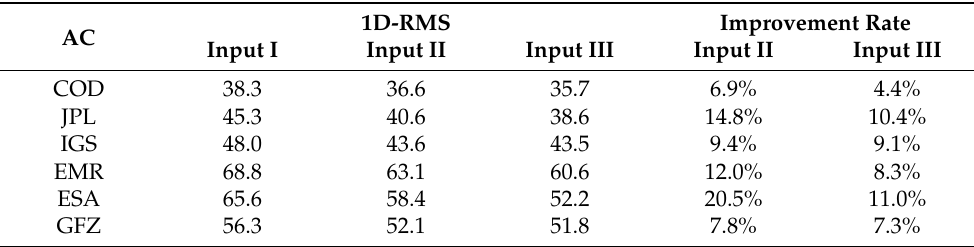
Figure 10. 1D ‐ RMS statistics of the kinematic orbit (unit: mm). Figure 10. 1D-RMS statistics of the kinematic orbit (unit: mm). Table 7. Statistic of differences in LEO kinematic orbit 1D ‐ RMS accuracy between boundary and Table 7. Statistic of differences in LEO kinematic orbit 1D-RMS accuracy between boundary and non ‐ boundary (unit: mm). non-boundary (unit: